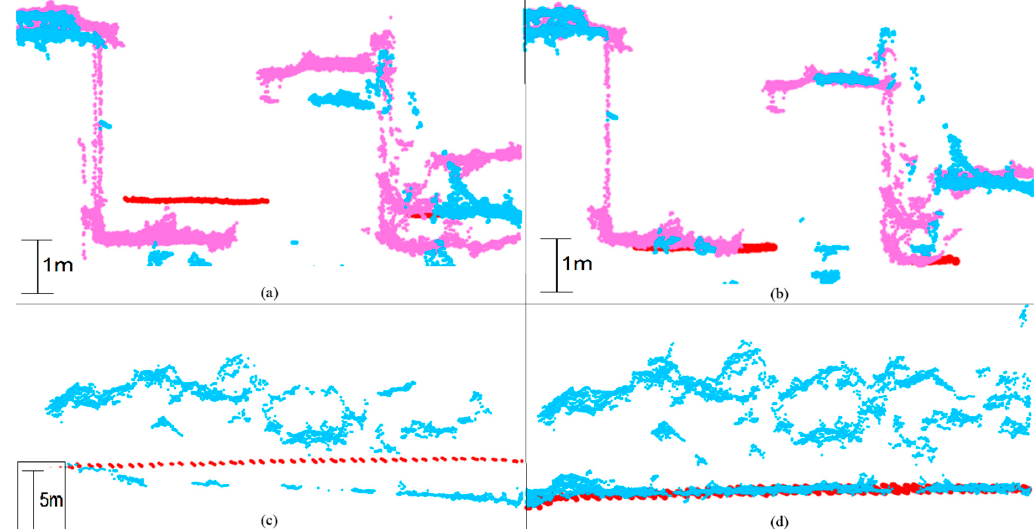
Figure 3. Sample vertical profiles to demonstrate the efficacy of our approach. Here, the ground points identified from the airborne laser scanning (ALS) data are shown in dark red, while point clouds derived from image pair matchings are shown in pink and blue. ( a ) The original vertical profile showing part of two tall buildings from the downtown area and the alleyway between them. The vertical co-registration is poor, especially at the rightmost part. ( b ) The height adjusted profile. The vertical co-registration of the digital aerial photogrammetry (DAP) point clouds are much better with respect to the ALS ground points and to each other; ( c ) The original vertical profile of an urban park area, with low tree density. The ground surfaces associated with ALS and the DAP point clouds do not coincide. ( d ) The corrected profile, where the ground surfaces coincide very well. The change in standard deviation ( ∆ SD, see (4)) between the original and adjusted point cloud elevations was quantified over the entire study area using 3 × 3 m pixels. Most areas (76.7%) registered relatively small change (less than 1.0 m). A substantial decrease in standard deviation (greater than 1.0 m), signaling better vertical co-registration, was recorded in 23.2% of the area. Meanwhile, the standard deviation increased substantially (more than 1.0 m) in only 0.05% of the study area. The spatial patterns of these changes over the whole study area are shown in Figure 4. From the figure (part (a)), it can be seen that our calibration method provides a decrease in standard